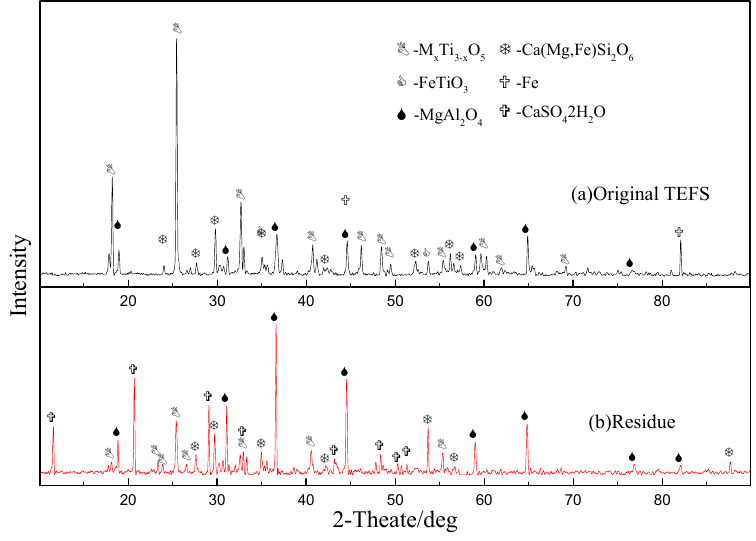
Figure 12. XRD patterns of original TEFS and residue.